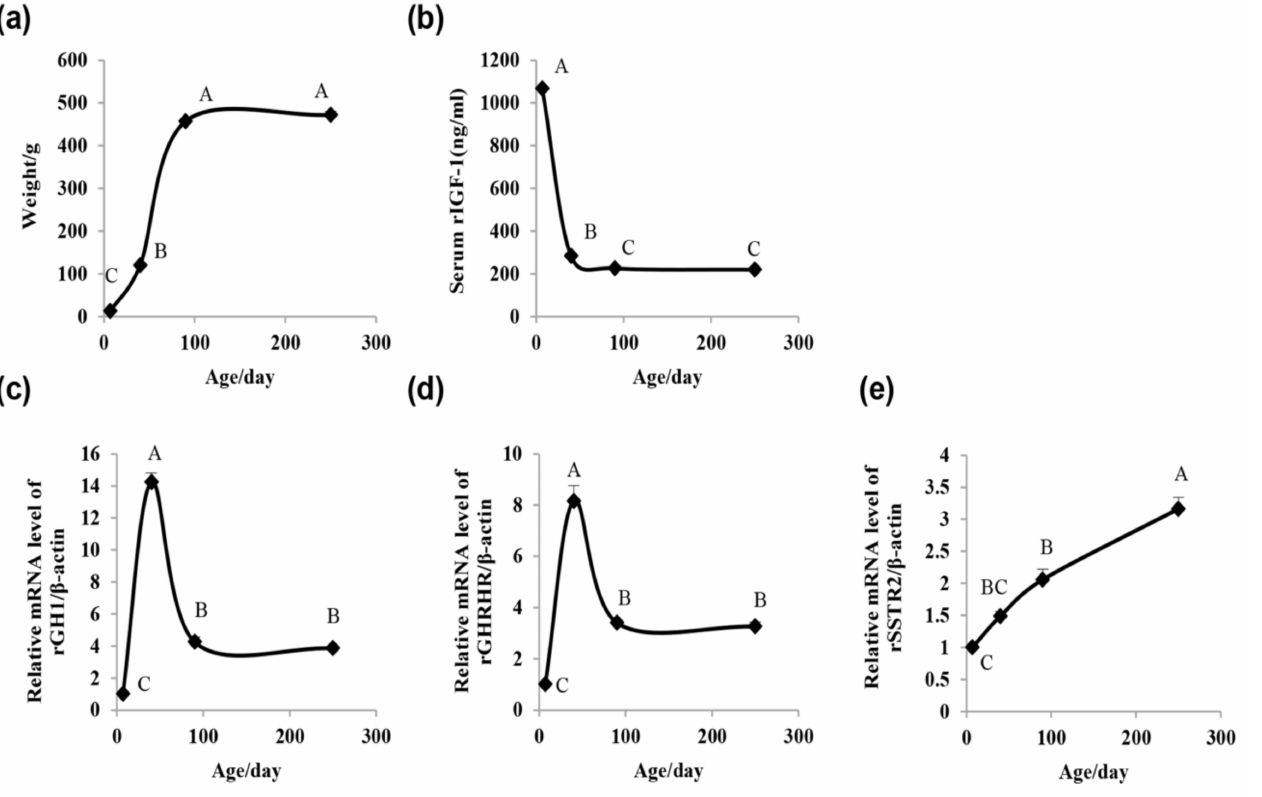
Figure 1. Rat growth curve, serum insulin-like growth factor 1 (IGF-1) concentration, and pituitary growth hormone 1 ( GH1 ), growth hormone-releasing hormone receptor ( GHRHR ), and somatostatin receptor 2 ( SSTR2 ) messenger RNA (mRNA) expression. ( a ) Sprague-Dawley (SD)rats growth curve. ( b ) SD-rat serum IGF-1 concentrations. ( c – e ) Alteration of pituitary GH1 , GHRHR , and SSTR2 mRNA expression. The four points in each figure represent the different ages (Day 7, Day 40, Day 90, and Day 250). The values are expressed as the means ± standard error of the mean (SEM). Means with different letters were significantly different ( n = 8; p < 0.01; ANOVA;